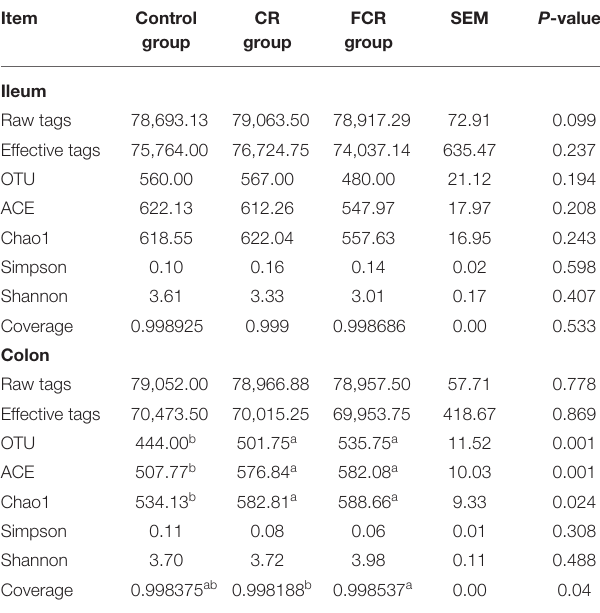
TABLE 3 | Effects of cassava residue (CR) or fermented cassava residue (FCR) on intestinal and hepatic secretory IgA and cytokine levels of piglets. Items Control group